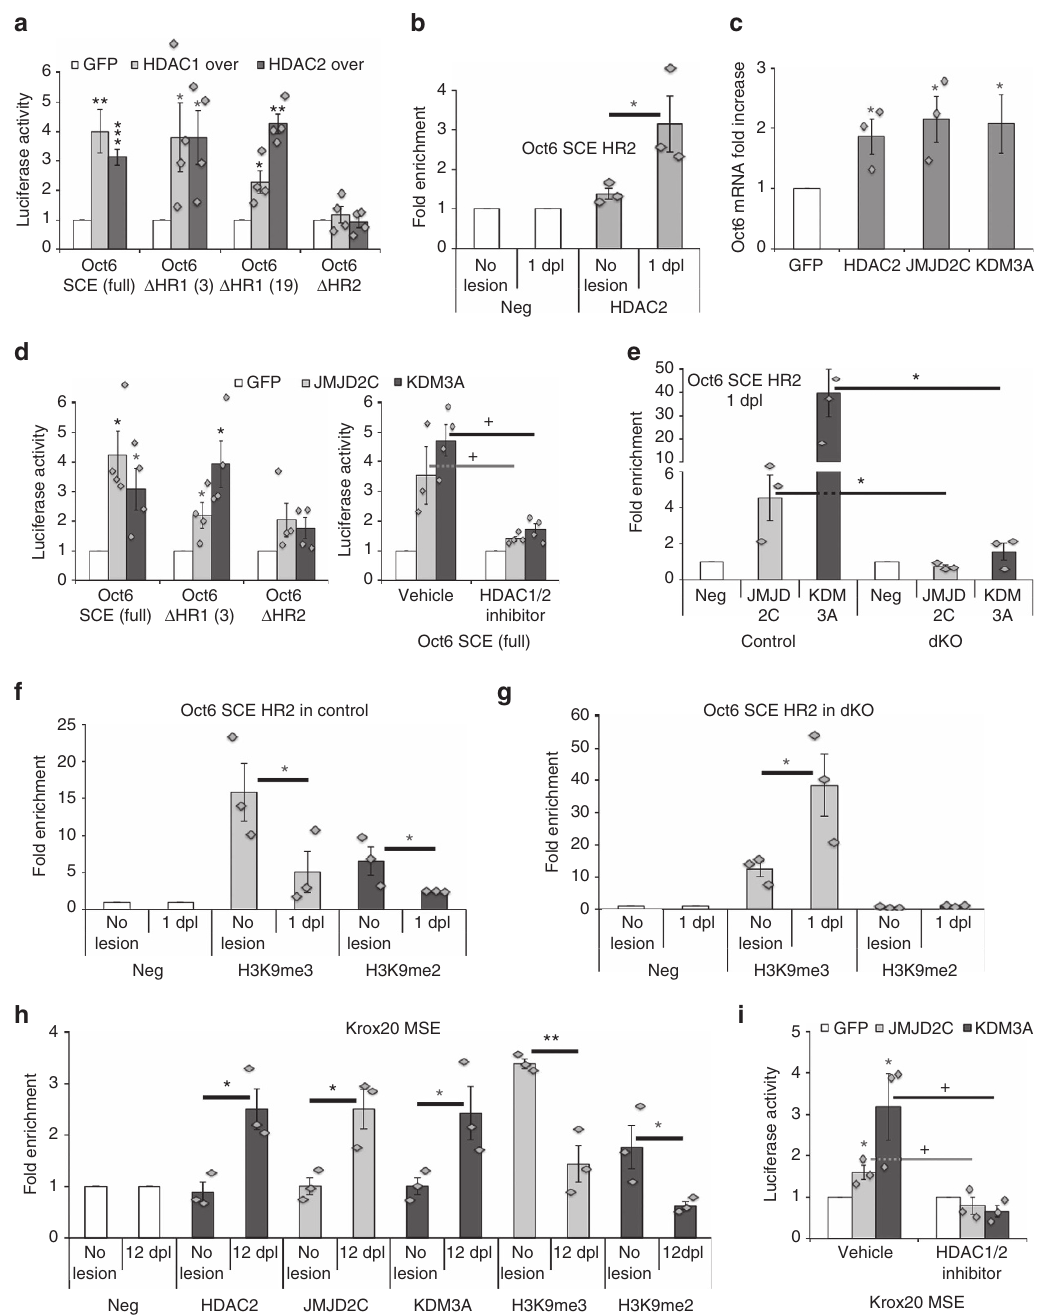
Figure 6 | HDAC2-dependent de-repression by JMJD2C and KDM3A. ( a , d ) Relative luciferase activity of the full Oct6 SCE, the D HR1 (constructs #3 and #19, ref. 35) and the D HR2 SCE showing that overexpression of HDAC1, HDAC2, JMJD2C or KDM3A increases the activation of the full Oct6 SCE or the D HR1 SCE, but not of the D HR2 SCE, compared with control GFP ( ¼ 1) in RSCs cultured under dedifferentiating conditions. The experiment carried out in the presence of the HDAC1/2 inhibitor Mocetinostat or its vehicle indicates that activation induced by JMJD2C or KDM3A is prevented by HDAC1/2 inhibition. ( i ) Similarly, activation of the Krox20 MSE induced by JMJD2C or KDM3A overexpression in RSCs cultured under redifferentiating conditions is prevented by HDAC1/2 inhibition. Chromatin immunoprecipitation of ( b ) HDAC2 and Flag (Neg ¼ 1) in unlesioned (no lesion) nerves or at 1 dpl, of ( e ) JMJD2C, KDM3A and Neg (GFP or flag) in control or dKO nerves at 1 dpl, of ( f , g ) H3K9me3, H3K9me2 and Neg (GFP or Flag) in unlesioned nerves and at 1 dpl in control ( f ) and dKO ( g ) on the Oct6 SCE HR2, and of ( h ) HDAC2, JMJD2C, KDM3A, H3K9me3, H3K9me2 and Neg on the Krox20 MSE in unlesioned nerves or at 12 dpl. ( c ) Oct6 mRNA fold increase in RSCs transfected with GFP ( ¼ 1), HDAC2, JMJD2C or KDM3A expression constructs and cultured under dedifferentiating conditions. Asterisks show significance compared with no lesion ( b , f – h ), to control ( e ) or to GFP ( a , c , d , i ), and crosses compared with vehicle ( d , i ). One-tailed (grey asterisks) or two-tailed (black asterisks or crosses) Student’s t -tests, unpaired ( d , i : HDAC1/2 inhibitor versus Vehicle; b , e – h ) or paired ( d , i : JMJD2C or KDM3A versus GFP; a , c ), P values: * P o 0.05, þ P o 0.05, ** P o 0.01, *** P o 0.001. Values, mean; error